Question: State the chart type depicted above.
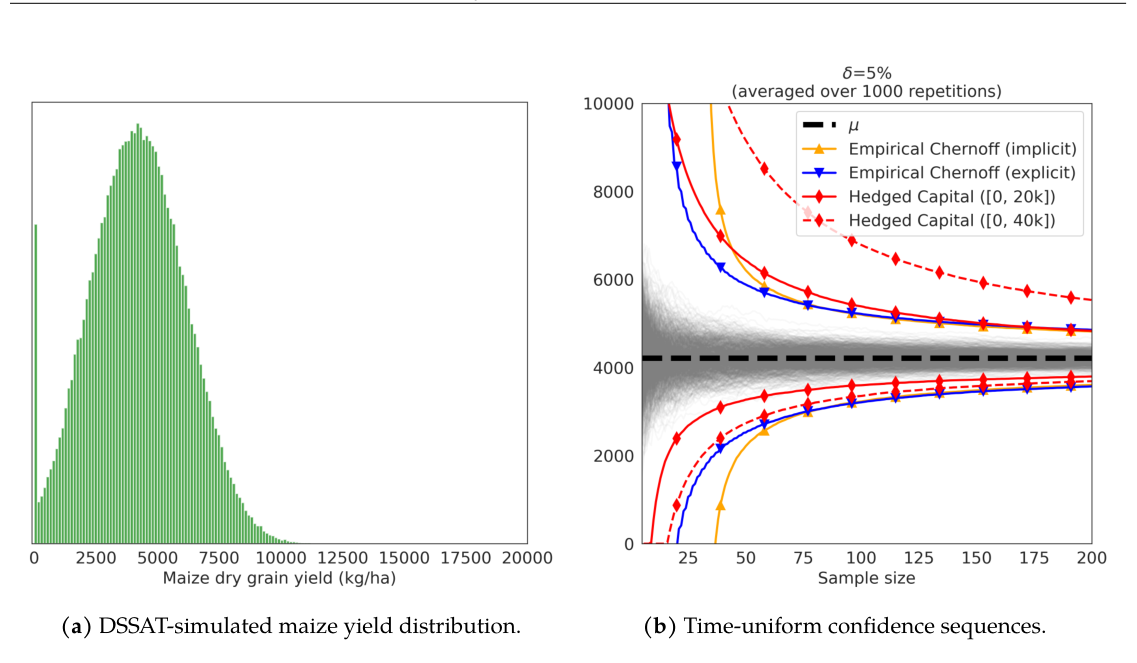
Answer: line